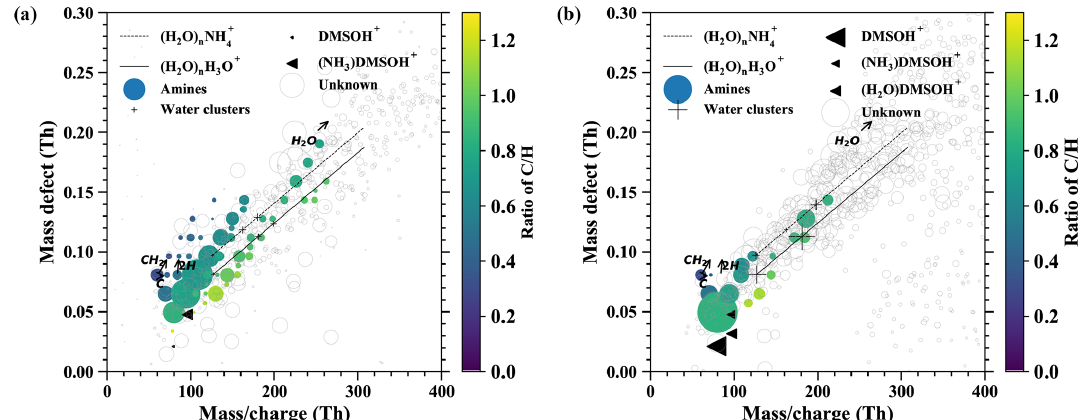
Figure E1. The mass defect for airborne ions in the continental boundary layer (a) and the free troposphere (b) . The data are averaged over